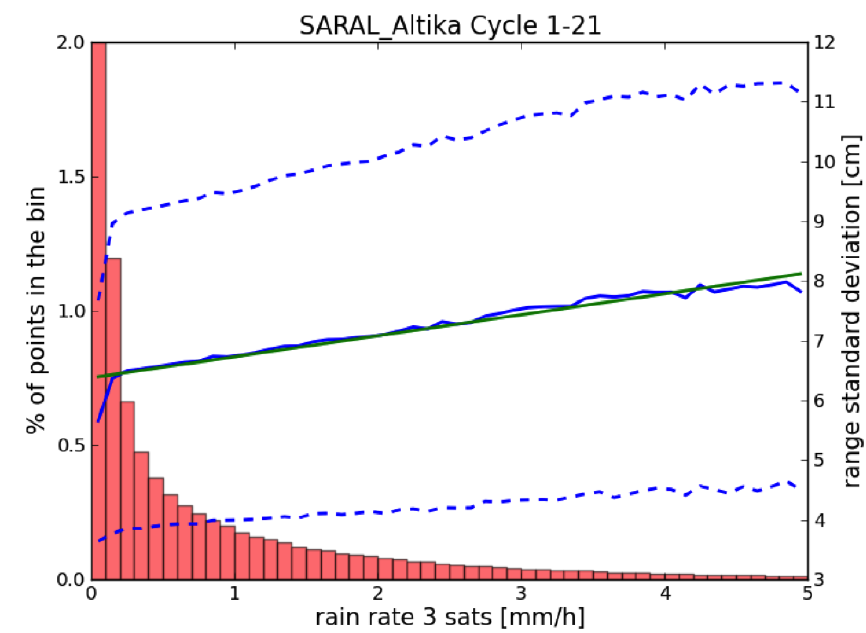
Figure 20. Variations of range std against rain rate. Please note that the first bin corresponding to dry measurements is truncated on the plot as it contains more than 70% of the measurement points. The plain blue line is the mean of the range standard deviation and the dashed blue lines represent the standard deviation for this mean. The green line is a linear regression of the mean (plain blue